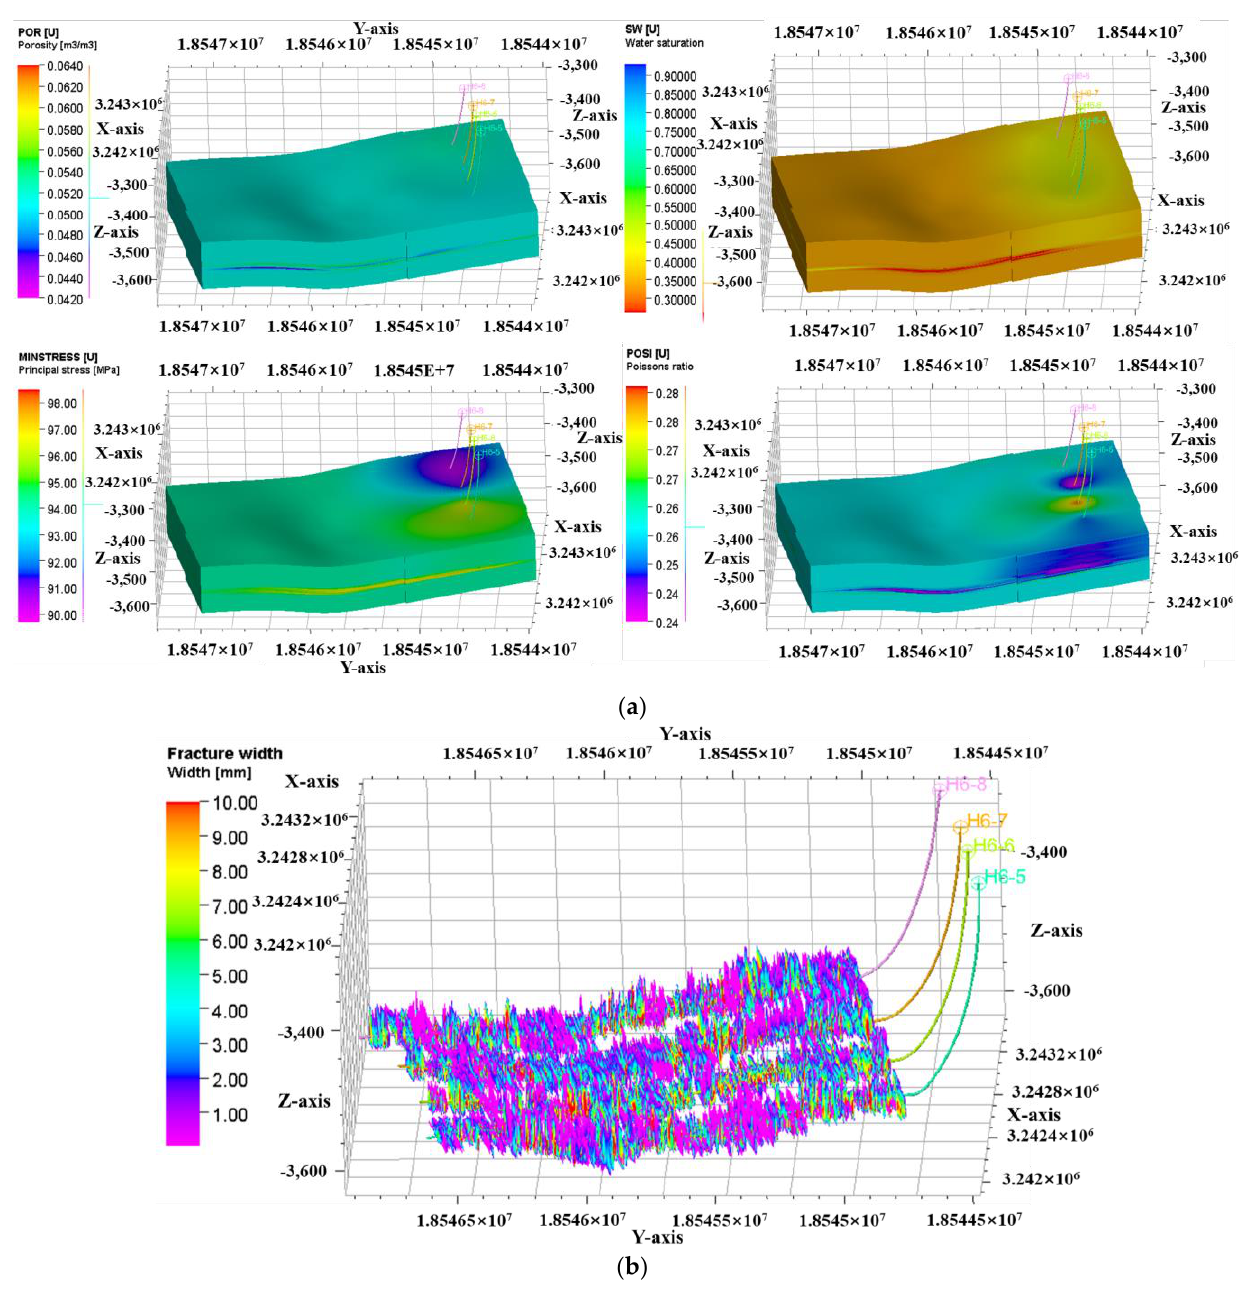
Figure 1. The results of platform: ( a ) 3D attribute model; ( b ) fracturing propagation result.